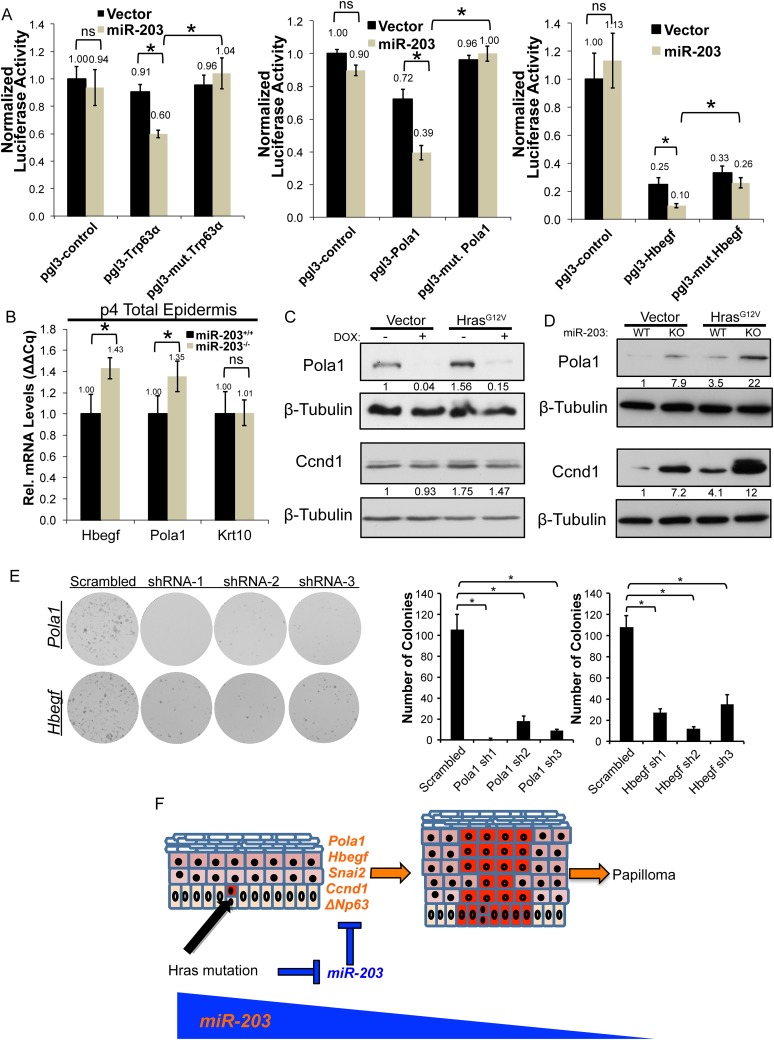
Hbegf and Pola1 are direct miR-203 target genes critical for keratinocyte proliferation.(A) 3′UTR luciferase reporter assays demonstrate that miR-203 directly targets Trp63 (positive control), Pola1, and Hbegf in keratinocytes (representative of n = 3 independent experiments, mean ± propagated standard deviation displayed, *p < 0.05, ns = non-significant, Student's t-test two-sided) (B) Hbegf and Pola1 are upregulated in miR-203−/− isolated epidermis (p4) (n = 8 and n = 10, miR-203+/+ and miR-203−/− animals respectively, mean ± SEM displayed, *p < 0.05). (C, D) Western blots from lysates with miR-203 overexpression (48 hr) or miR-203 ablation. (E) shRNA knockdown of Hbegf or Pola1 impairs keratinocyte colony formation ability (representative of n = 3 independent experiments, *p <0.05, mean ± standard deviation displayed). (F) Model for the mechanism of miR-203 in restricting Hras-initiated tumorigenesis.